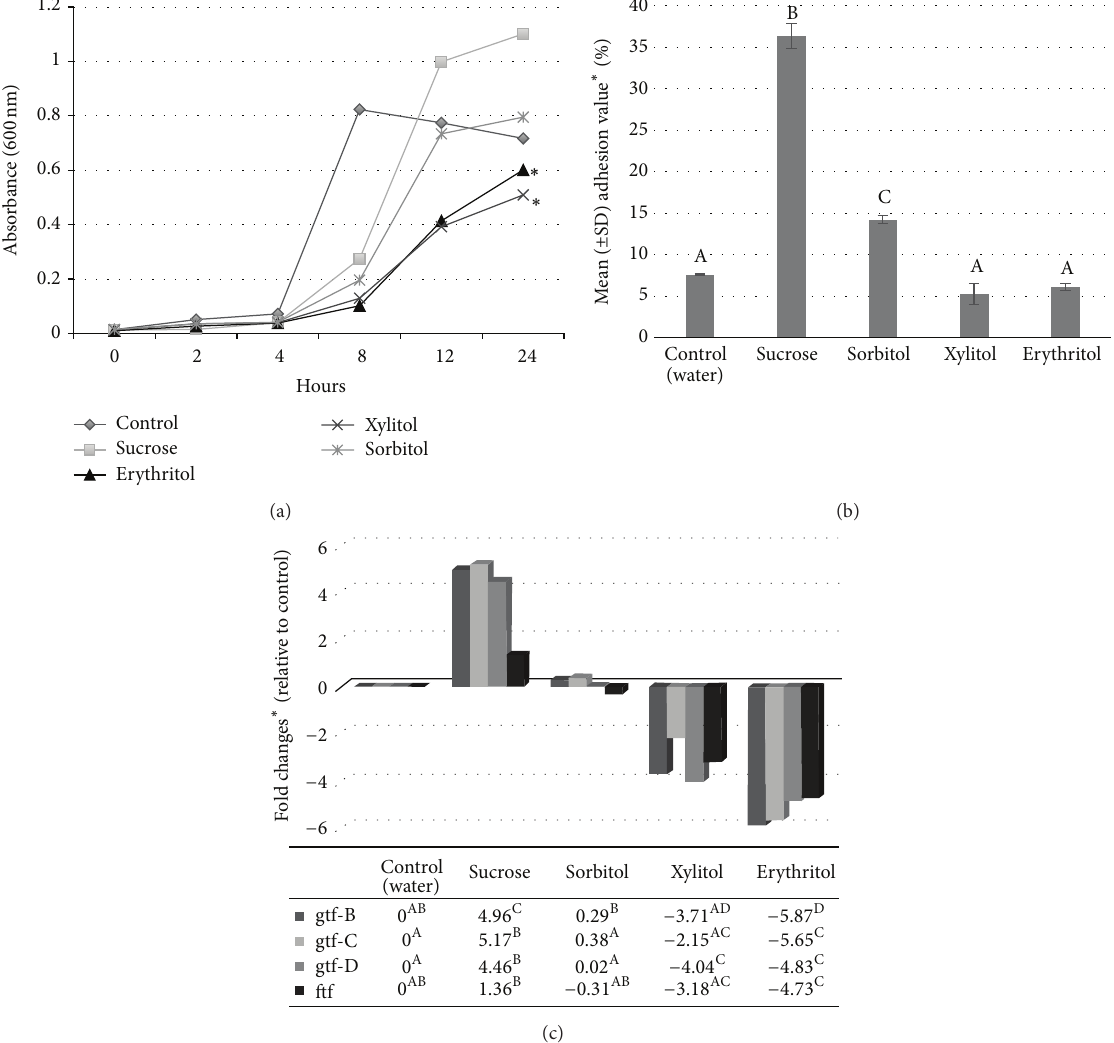
Figure 6: Growth (a), adhesion (b), and gene expression ((c); gtf and ftf ) of S. mutans (strain ATCC 31989) in the presence of 10% sucrose, erythritol, xylitol, or sorbitol (adapted from Park et al. [17]). 𝑝 < 0.05 when compared to control (water) using analysis of variance (ANOVA) repeated measures (a). SD: standard deviation; overall difference ( 𝑝 < 0.05 ) based on the Kruskal-Wallis test. A , B , C , D The same letter indicates no significant difference ( 𝑝 < 0.05 ) based on Mann-Whitney testing (b). ∗ 𝑝 < 0.05 , based on the Kruskal-Wallis test, A , B , C , D the same letter indicates no significant difference based on Mann-Whitney testing